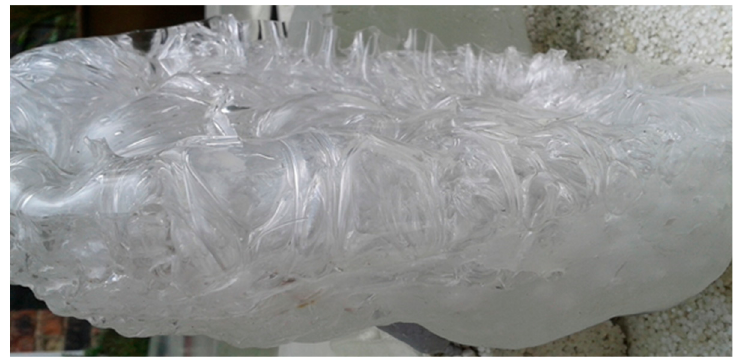
Figure 12. Gas bubbles in the glass as a result of pouring hot glass into the plaster mold; created